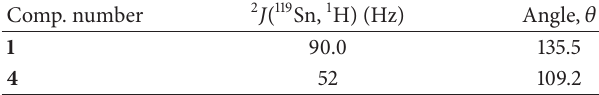
Table 4: (C–Sn–C) angles ( ∘ ) based on NMR parameters. Comp.